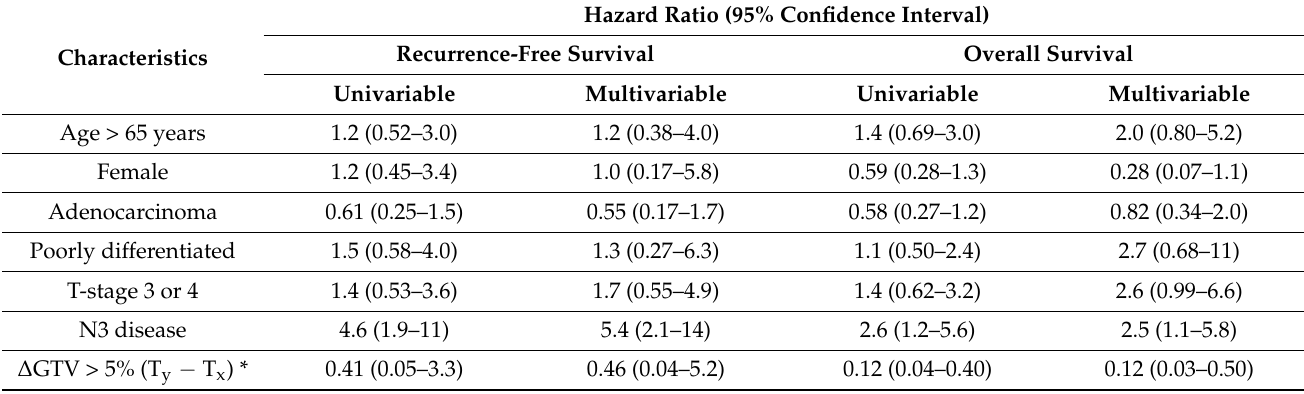
Figure 2. Kaplan–Meier plots showing ( A ) recurrence ‐ free survival ( p = 0.39) and ( B ) overall survival ( p < 0.0001) for patients with a change in gross tumor volume (GTV) greater than 5% during at least one week of chemoradiation ( Δ GTV > 5% (T y – T x )) compared with patients having a change in GTV of less than 5% (referent) during at least one week of treatment.